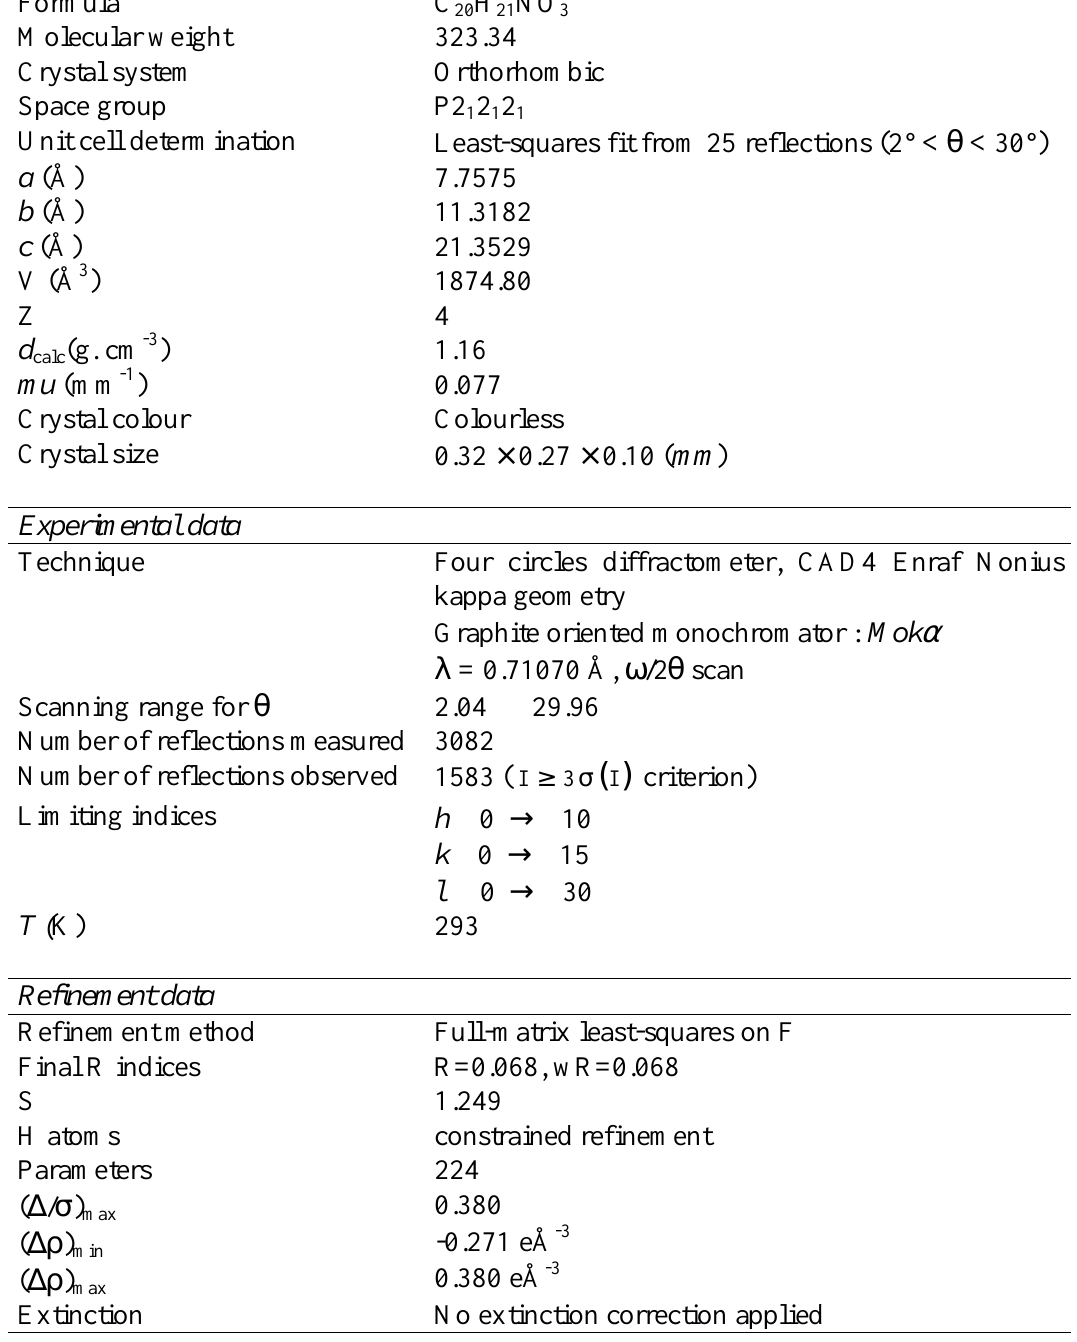
Table 4. Crystallographic data and experimental details for C